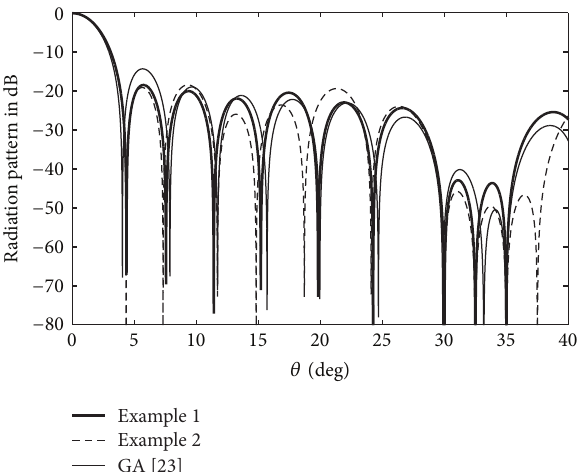
Figure 2: The normalized radiation pattern of 28-element linear array.